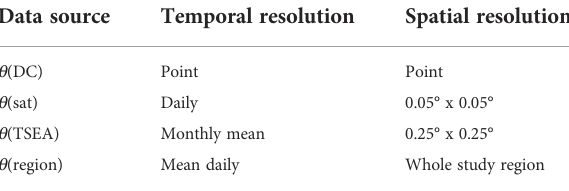
TABLE 1 Temporal and spatial resolution by data